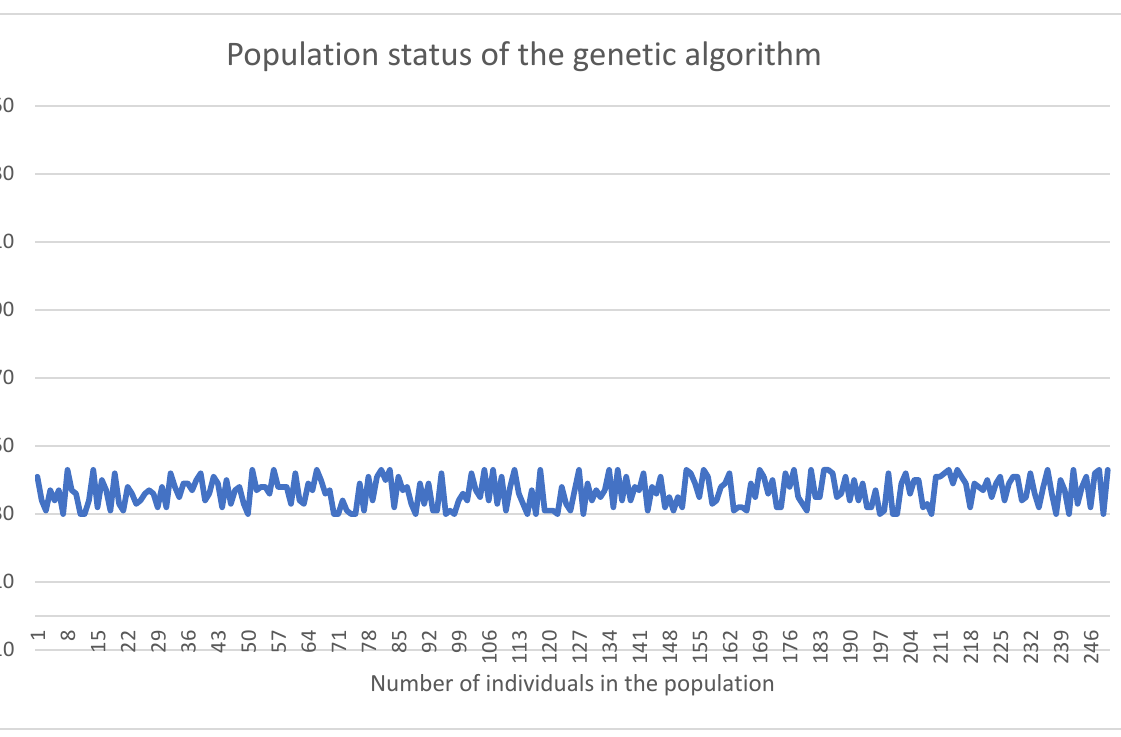
GPGPU + CPU, as well as using CPU only (see Table 11). CPU, as well as using CPU only (see Table